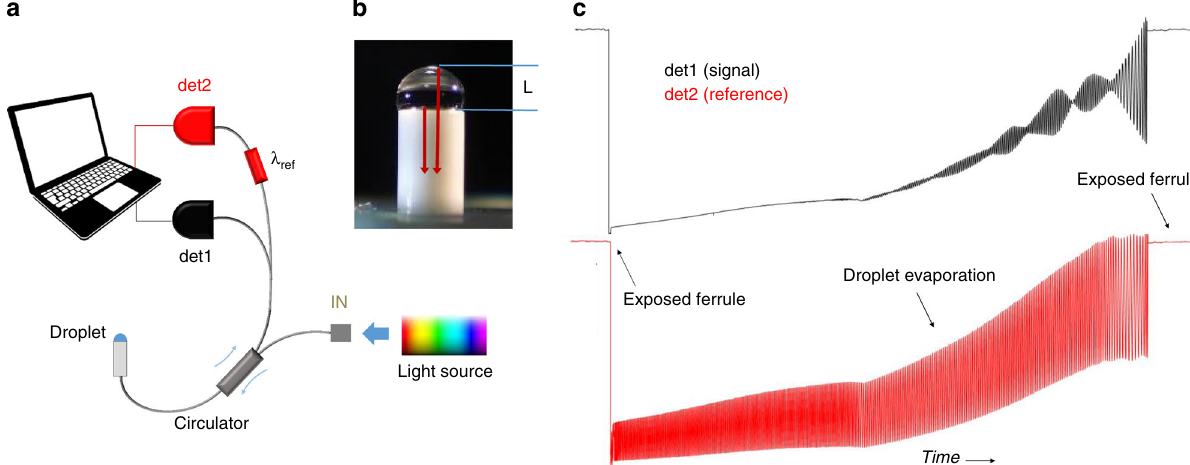
Fig. 1 Experimental setup. a Scheme of the fi ber-optic droplet spectrometer; b detail of a droplet of thickness L sitting on the fi ber connector ’ s ferrule (water, for better visualization). The radiation re fl ected at the two droplet boundaries is indicated with red arrows; c signals from detectors det1 and det2 upon deposition and evaporation of an isopropyl alcohol droplet, obtained with a supercontinuum radiation source at the